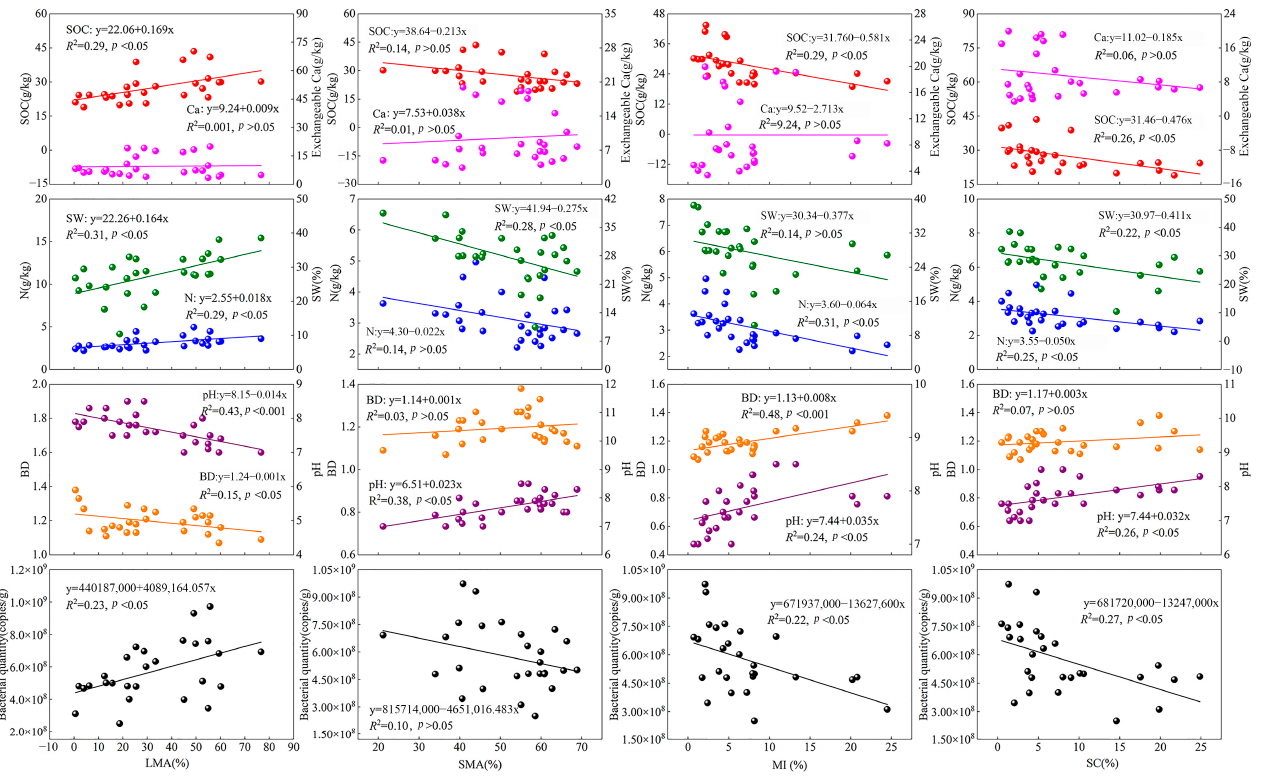
Figure 4. Relationships between the mass proportions of soil aggregates and soil properties. SOC—soil organic carbon; N—nitrogen; SW—soil water; BD—bulk density; LMA—large macroaggregates; SMA—small macroaggregates; MI—microaggregates; SC—silt + clay fractions.